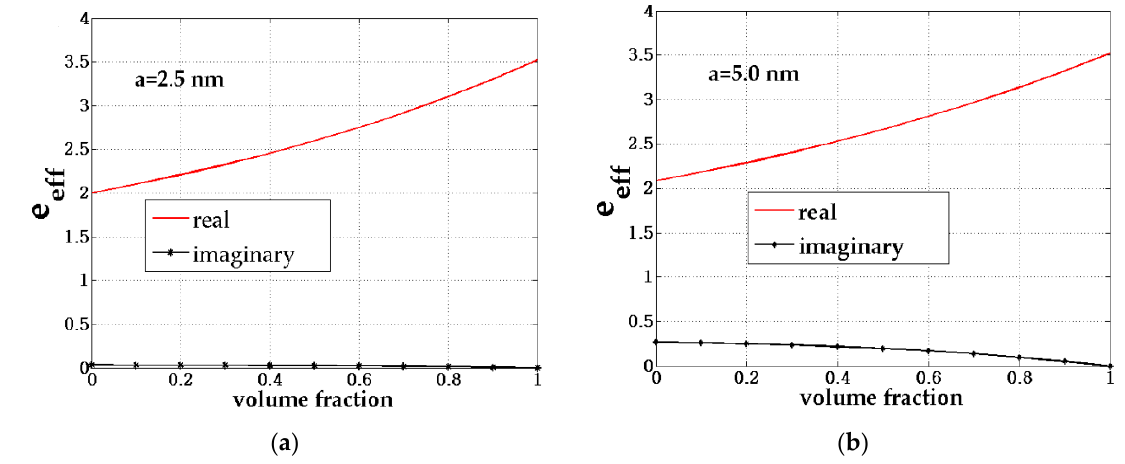
Figure 9. The composite effective permittivity with variations in the volume fraction ( F ) of the composite for the fixed size of the core-shell of ( a ) 2.5 nm and ( b ) 5.0 nm.